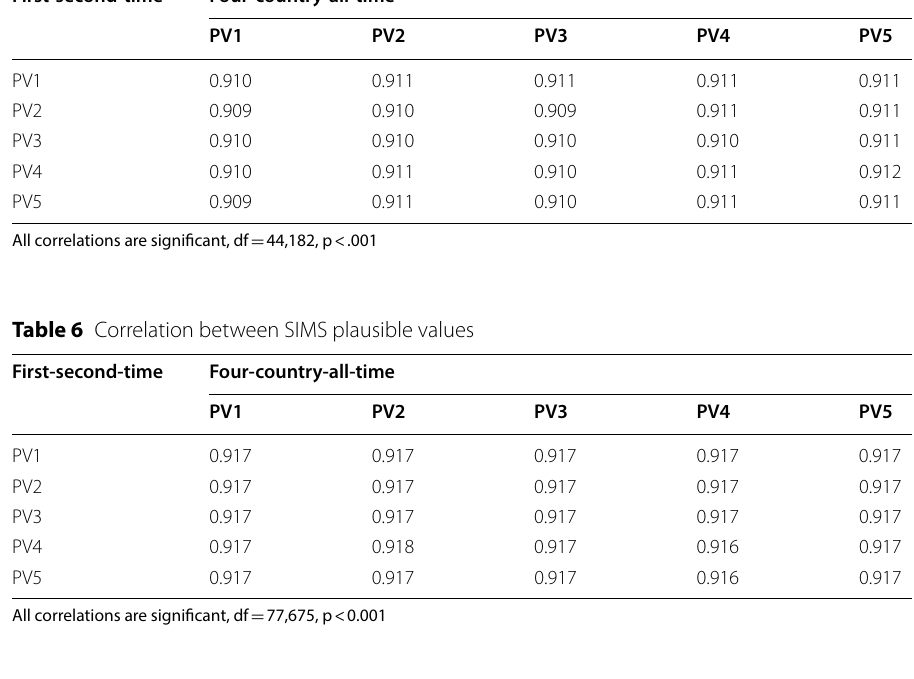
Table 5 Correlation between FIMS plausible values